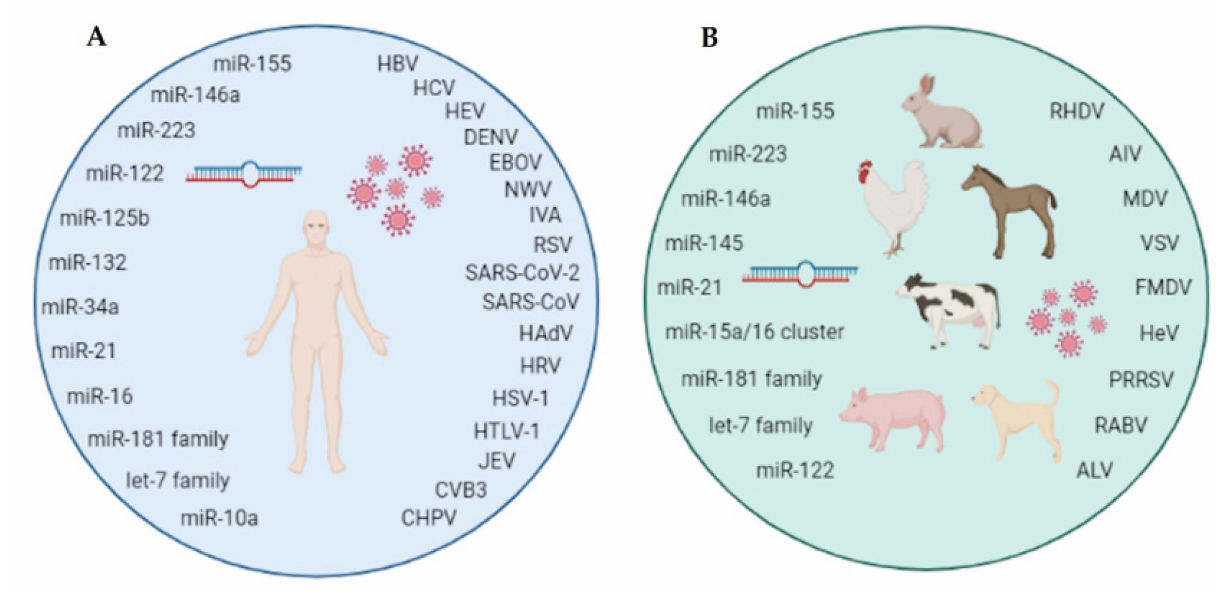
Figure 2. Key miRNAs: ( A ) in human viral infections and ( B ) in animal viral